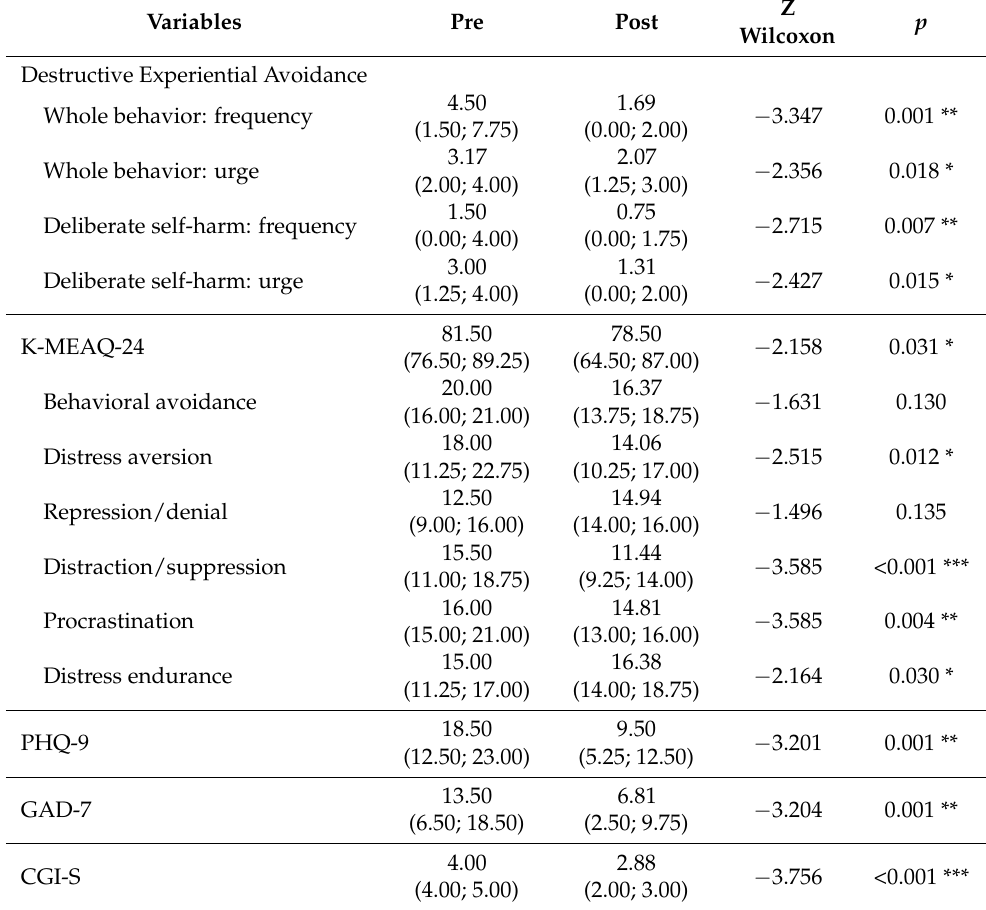
Table 3. Wilcoxon signed rank test results for pre- and